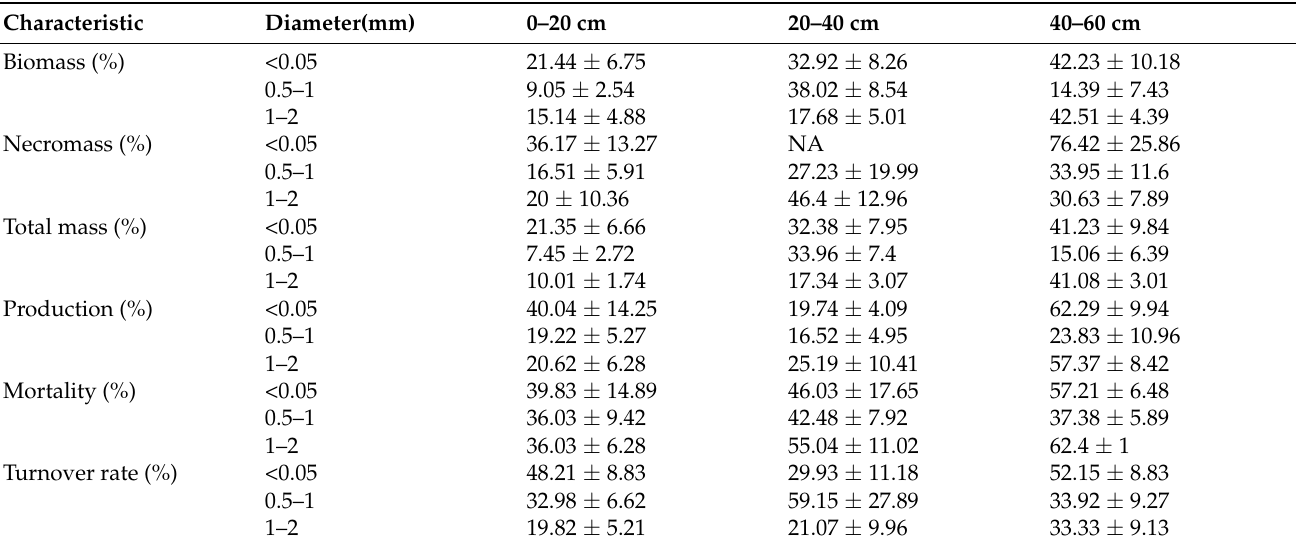
Table 4. Mean percentage changes of the fine-root characteristics within different diameter classes for all of the thinning treatments at different soil depths (mean ± SE; n = 4).